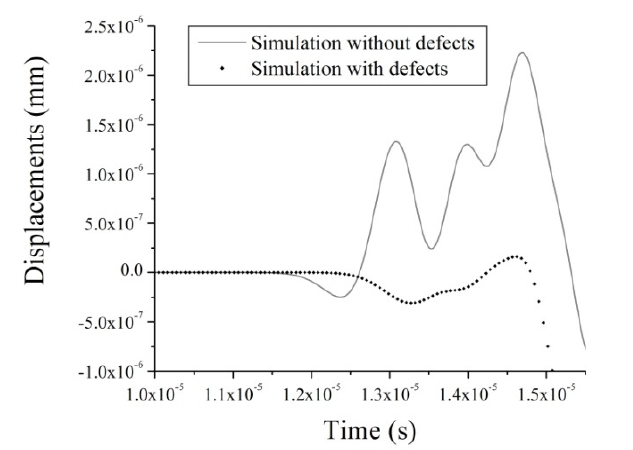
Figura 11: Spostamenti normali alla superficie misurati con l’approccio numerico sul lato opposto del